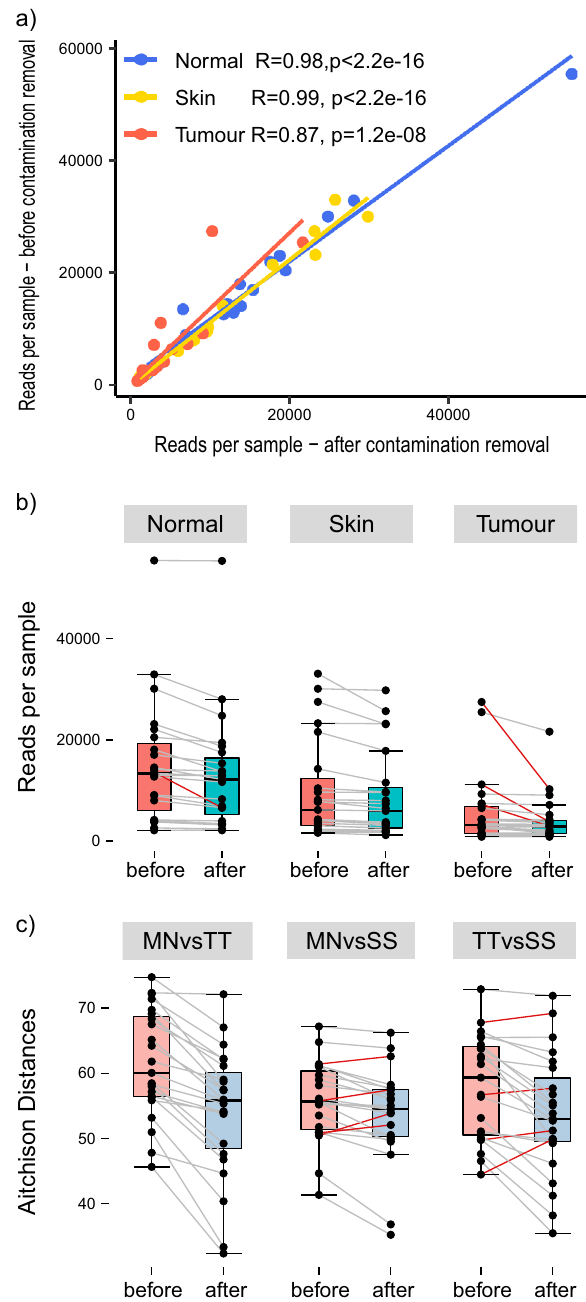
Figure 1. Investigation of the effect of contamination removal on the number of sequencing reads per patient sample. (a) Correlation of reads per sample by tissue type prior to, and following, contamination removal. ( b) Box plots of reads per sample by tissue type, prior to, and following, contamination removal. Red lines indicate samples that lost more than half their total reads following contamination removal. ( c) Calculation of pairwise distances, before and after contamination removal, between tumour tissue (TT), matched normal tissue (MN), skin swabs